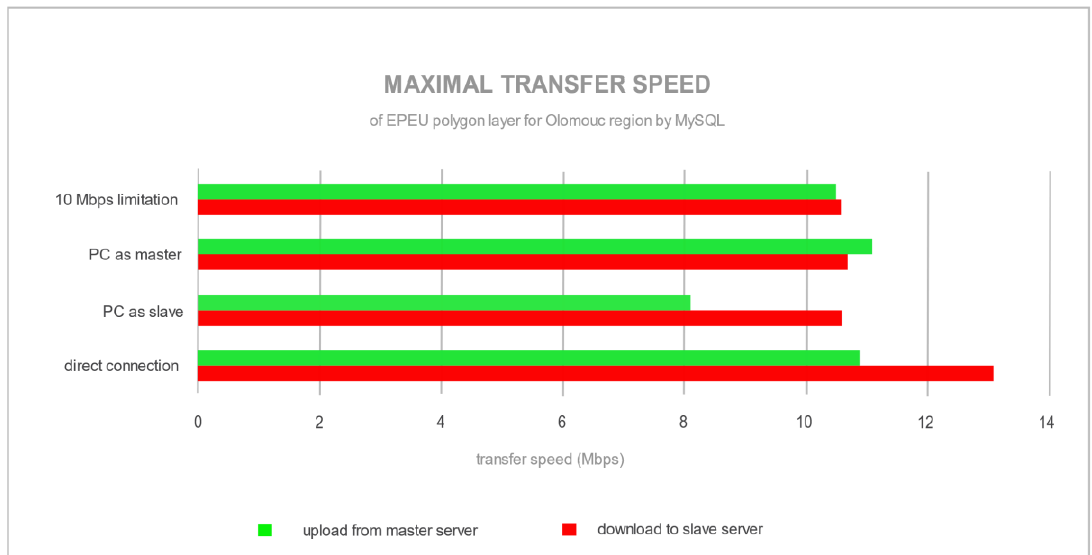
Figure 8. Average replication speed of the EPEU layer for different cluster configurations by MySQL.